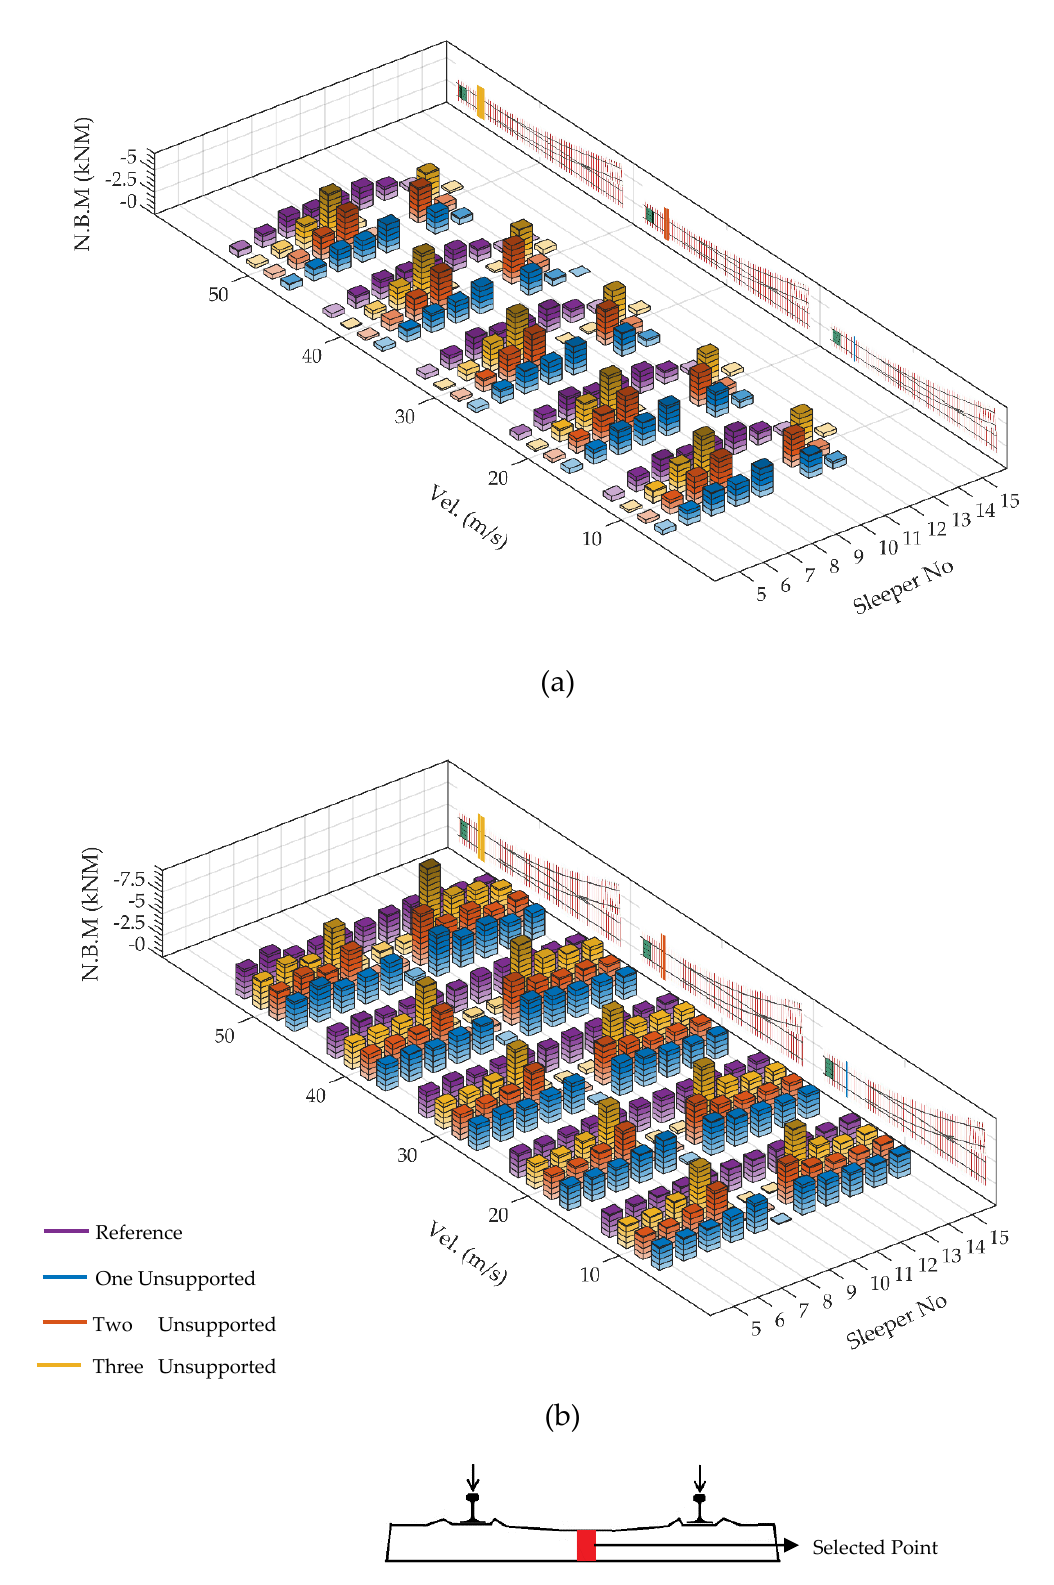
Figure 16. The distribution of negative bending moments over the bearers when unsupported bearers exist at normal track section: ( a ) at particular time when the front wheel is on the bearer with number 10; ( b ) when maximum occurs at each bearer.